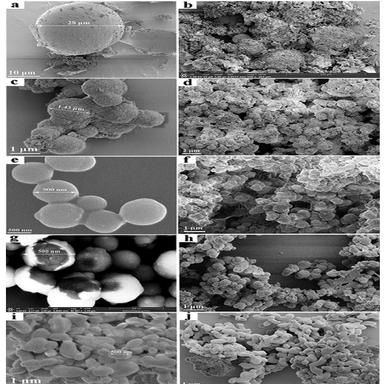
SEM images of samples prepared by addition of (a, b) 0.6 mL, (c, d) 0.8 mL (MPCM1), (e, f) 0.9 mL (MPCM2), (g, h) 1.0 mL (MPCM3), and (i, j) 1.5 mL of Triton X-100.